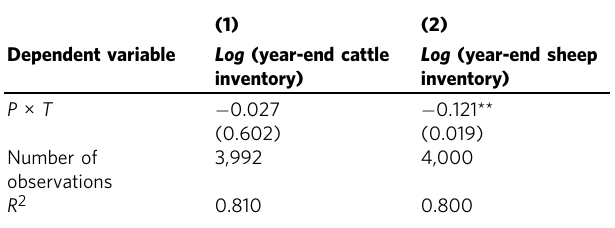
Table 4 Estimated impacts of the Grassland Ecological Compensation Program (GECP) on livestock production: county level.